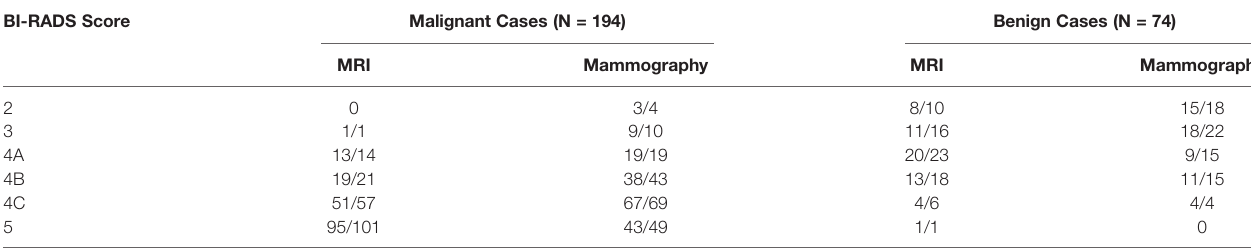
TABLE 4 | The number of correctly diagnosed cases made by the combined radiomics model in each BI-RADS category. BI-RADS Score